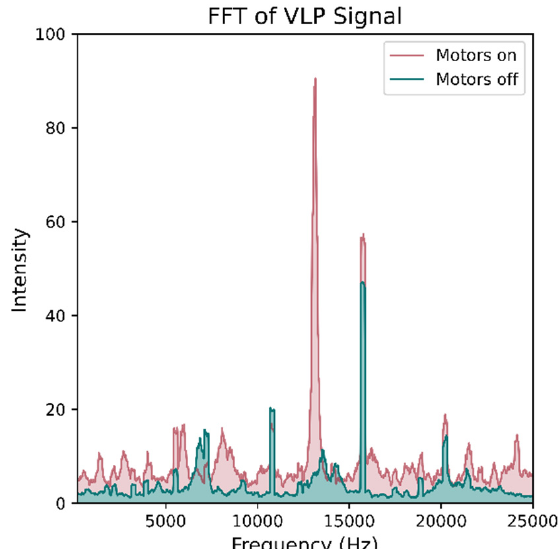
Figure 10. Visualization of noise caused by the EMI of the vacuum’s motors. The green plot shows a DFT of the VLP signal when the motors are off and luminaires are operating. The distinct peaks represent signals detected from the luminaires in proximity. The red shows the DFT of the received signal at the same location but with the vacuum motors on. In addition to a large peak at around 12.5 kHz, the background noise level has increased over the entire frequency range.